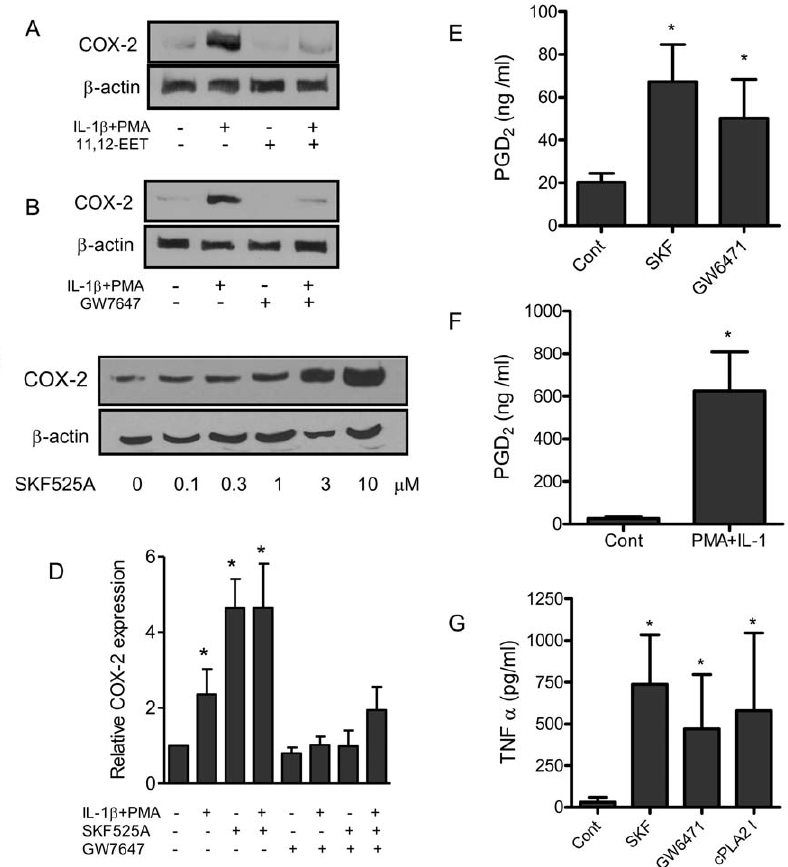
Figure 4. Epoxygenase inhibition induces pro-inflammatory signals in human and murine monocytes in vitro. (A and B) COX-2 protein induced in THP-1 cells by a combination of IL-1 b (10 ng/ml) and PMA (1 nM) for 24 h is inhibited by co-incubation with either (A) 11,12-EET (1 m M) or (B) the selective PPAR a ligand GW7647 (10 nM). b -actin was measured to ensure equal loading of proteins. Data is representative of n=3 separate experiments. (C and D) Epoxygenase blockade alone is sufficient to induce COX-2 in THP-1 monocytes. (C) SKF525A 0.1–10 m M gives a concentration- dependent induction of COX-2 protein. Data is representative of n=4 separate experiments. (D) Epoxygenase blockade induces COX-2 in THP-1 cells which is reversed by the selective PPAR a agonist GW7647 (10 nM). Compared to the established pro-inflammatory combination of IL-1 b and PMA (used at optimal concentrations for COX-2 induction), SKF525A gives a robust induction of COX-2. Data represents mean 6 SEM of n=4 separate experiments. *denotes p , 0.05, by one-sample t-test treatments compared to untreated cells. (E) The COX derived prostanoid PGD 2 is also induced in THP-1 cells by epoxygenase (SKF525A 10 m M) or PPAR a blockade (GW6471 10 m M) or (F) a combination of IL-1 b (10 ng/ml) and PMA (1 nM) for 24 h. (G) Similarly, TNF a is induced in THP-1 cells by epoxygenase (SKF525A 10 m M), PPAR a blockade (GW6471 10 m M) or cPLA 2 (AACOCF 3 30 m M) inhibition over 24 h. *denotes p , 0.05 by Wilcoxon signed rank test treatments compared to untreated cells.